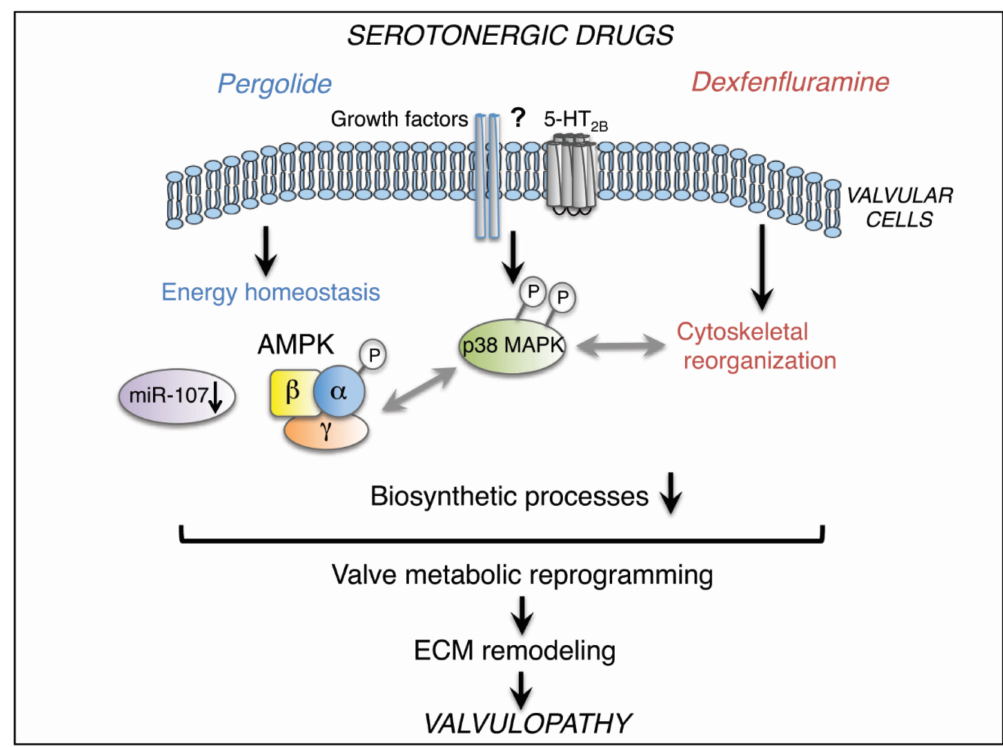
Figure 6. Schematic summary: chronic use of pergolide or dexfenfluramine activates p38 MAPK in valvular cells. Specifically, pergolide triggers AMPK- and miR-107-dependent homeostasis processes, whereas dexfenfluramine a ff ects cytoskeletal organization. Drug-induced alterations of valve homeostasis and cytoskeleton are associated with net inhibition of biosynthetic processes that reflect valve metabolic reprogramming, leading to ECM remodeling and valvulopathy. Gray arrows represent hypothetical